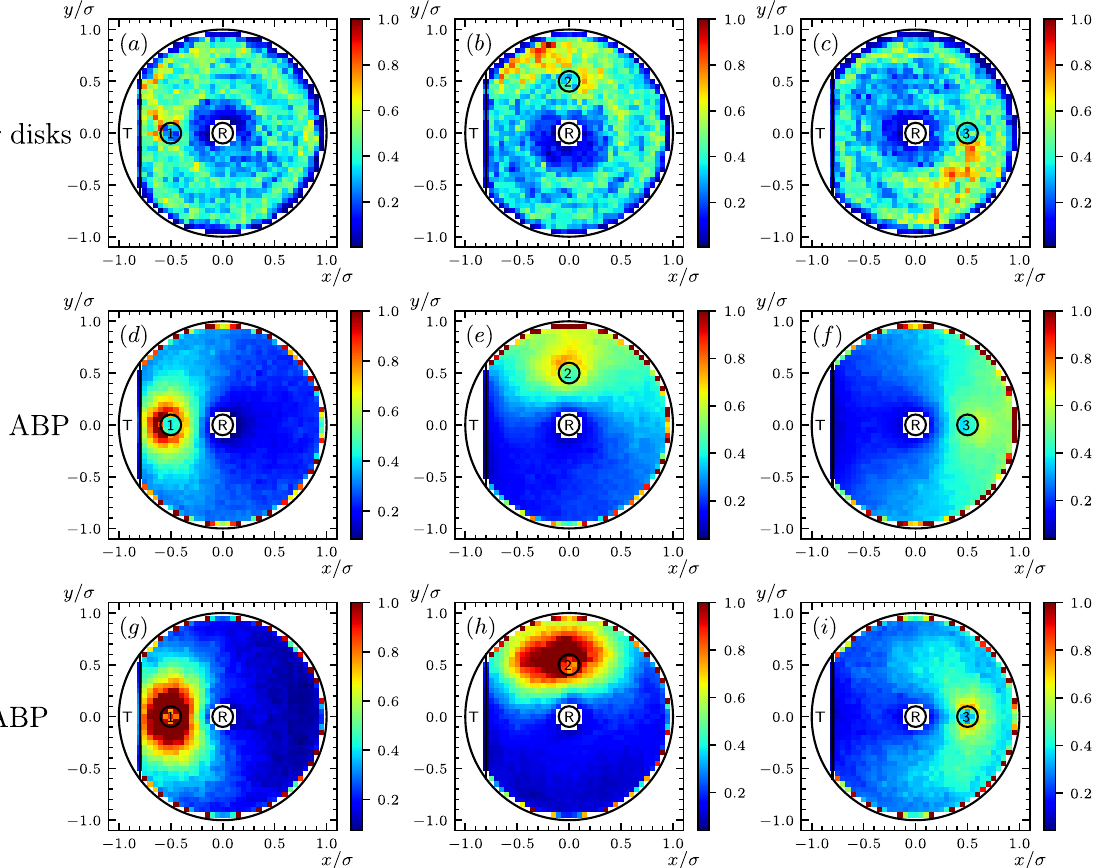
Figure 2. Survival path density m s ( r | r a ) —for three different initial conditions ( a = 1, 2, 3 )—extracted from experiment ( a–c ) by tracking the motion of the camphor particles, evaluated from numerical simulation in the standard ABP model ( d–f ), and in the chiral ABP model ( g–i ).